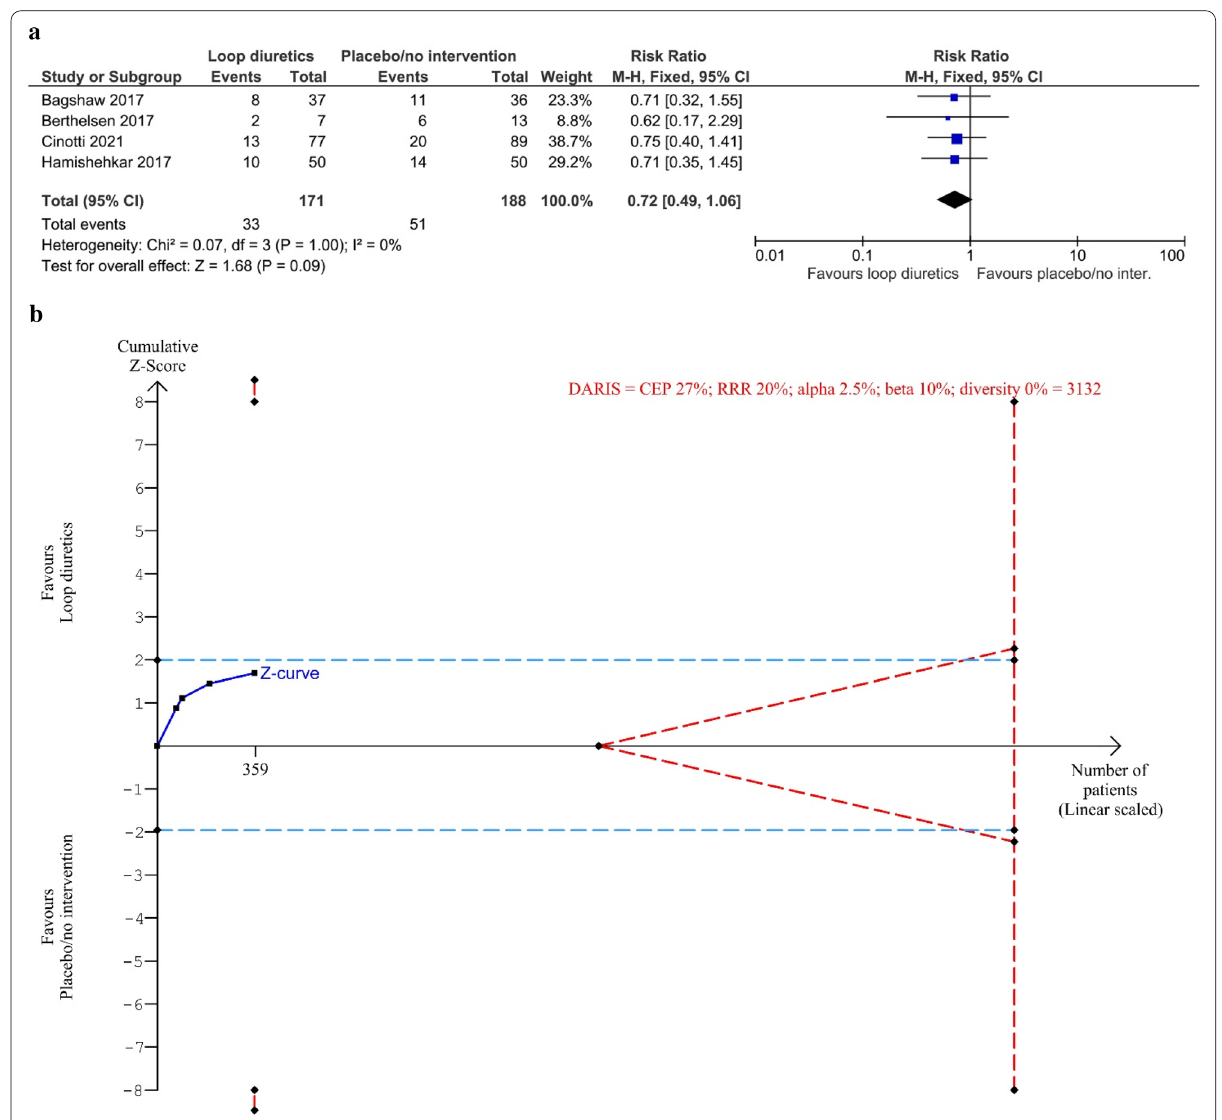
Fig. 2 Meta-analysis and TSA for all-cause mortality for loop diuretics vs. placebo/no intervention. a Meta-analysis. b TSA. The diversity adjusted required information size (DARIS) was calculated according to a mortality proportion in the control group (CEP) of 27%; risk ratio reduction (RRR) of 20% in the experimental intervention group; alpha of 1.7%; a beta of 10% (90% power); and diversity 0%. The DARIS was 3132 participants. The cumulative Z-curve (blue line) did not cross the trial sequential boundaries for benefit or harm or the inner-wedge futility line (red outward sloping red lines) nor the DARIS. The light blue dotted lines show naïve conventional boundaries (alpha